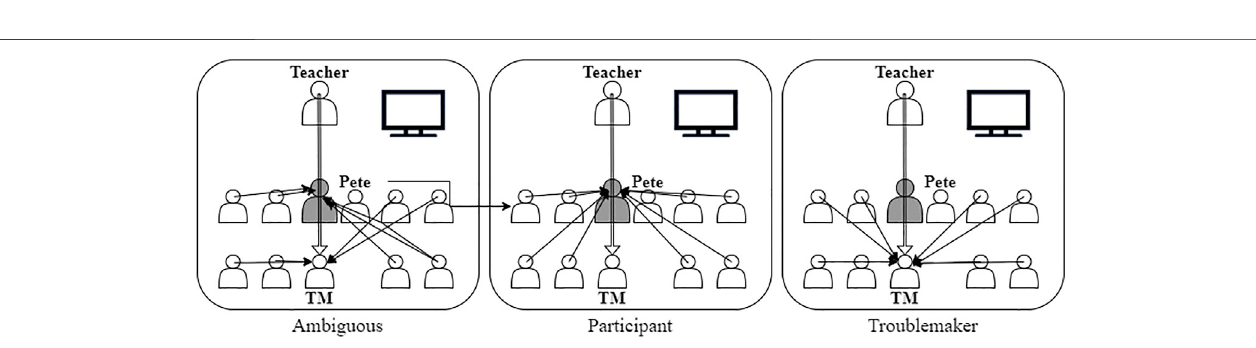
FIGURE 4 | Pete, virtual agent and supportive fellow student: face and body (assets by JBGarraza, 2021a).